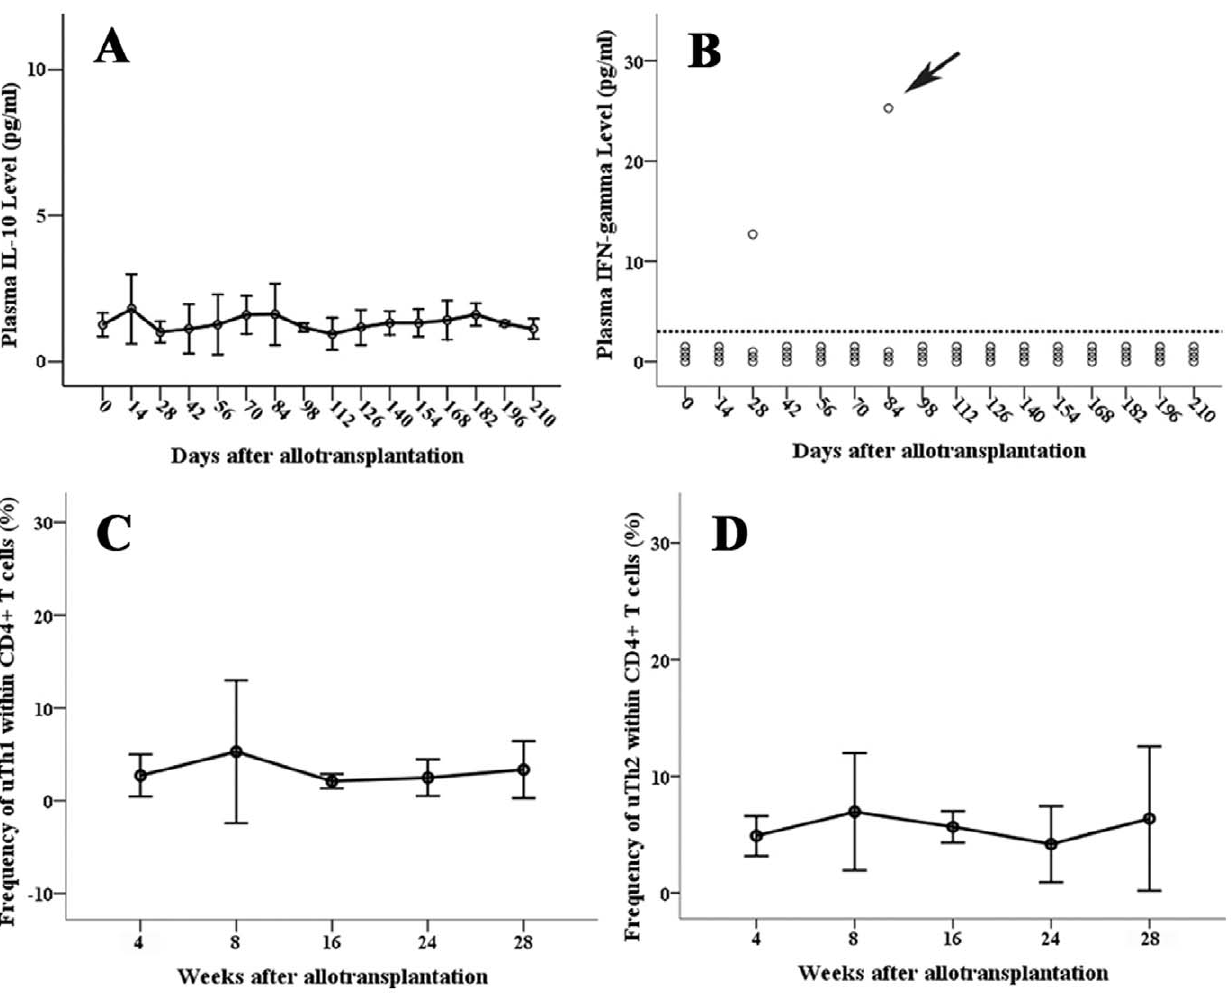
Figure 1. Immunological parameters of patients having no GVHD (No GVHD- external control). Serial plasma IL-10 (1A), IFN- c (1B), and the frequency of uTh1 (1C) and uTh2 (1D) within CD4 + T cells during the post-transplant course of patients having no GVHD. Error bars in figure 1A, 1C, and 1D represent 2X the standard error of the mean. The dash line on figure 1B represents the detected limit of plasma IFN- c . Arrow on figure 1B represents the concomitant herpes zoster infection of patient No. 4 at that time